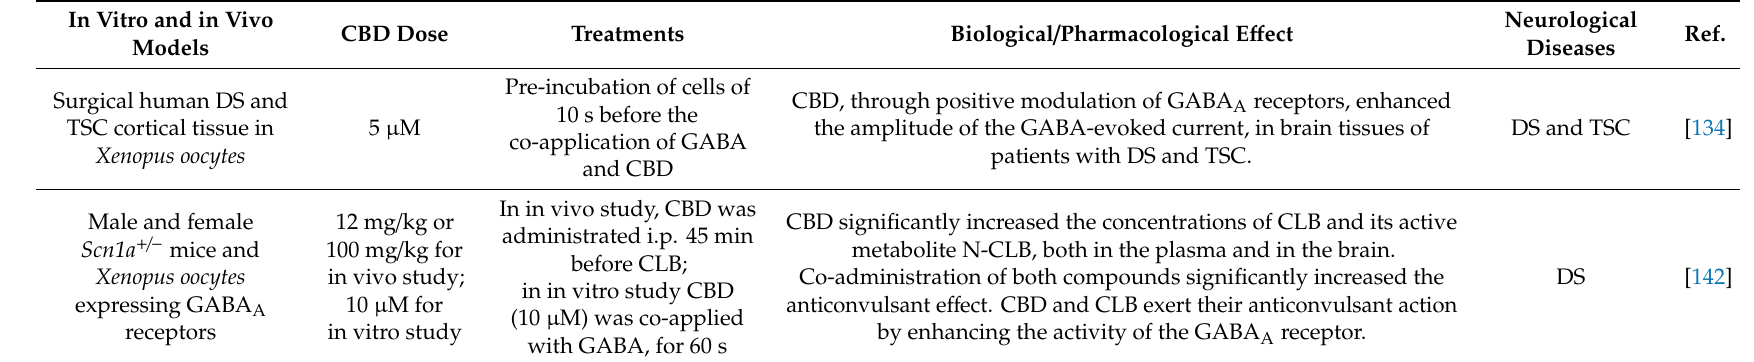
Table 6. Neuroprotective e ff ects of CBD in di ff erent neurological diseases through positive allosteric modulation of GABA A